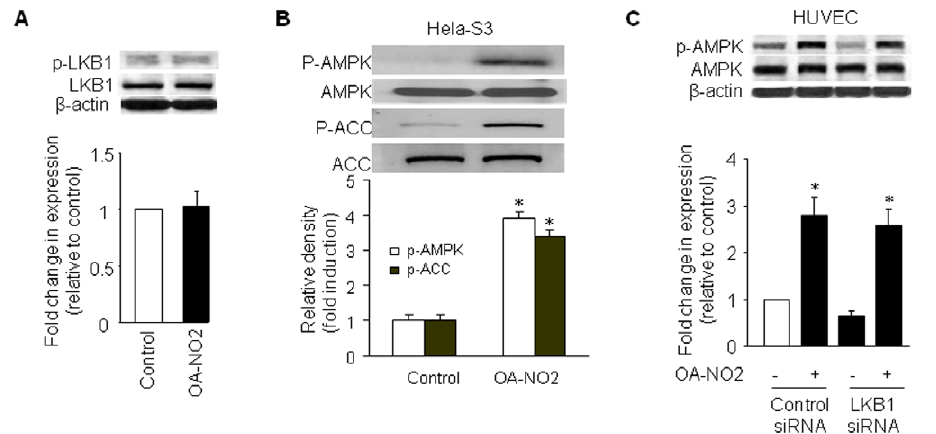
Figure 2. Activation of AMPK by OA-NO 2 does not require LKB1. A ) Phosphorylation of LKB1 Ser428 was not affected by OA-NO 2 in BAECs. Confluent BAECs were exposed to 2.5 m M OA-NO 2 for 16 h, and phosphorylated LKB1-Ser428 was detected by a phospho-specific antibody in western blots. The blot is a representative of three blots obtained from three independent experiments. Lower panels : summary data ( n =3). B ) LKB1 is not required for AMPK activation by OA-NO 2 . Confluent LKB1-deficient Hela-S3 cells were exposed to 2.5 m M OA-NO 2 for 16 h, and then AMPK and ACC phosphorylation were assayed as described in Materials and Methods. The blot is representative of three blots obtained from three independent experiments. Lower panels : summary data (* p , 0.05 vs. control; n =3). C ) LKB1 siRNA did not abolish OA-NO 2 -stimulated AMPK activation in HUVECs. HUVECs were incubated with LKB1-specific siRNA or control siRNA for 48 h and then treated with OA-NO 2 or vehicle for 16 h. After treatment, cell lysates were analyzed for LKB1 protein levels and AMPK phosphorylation at Thr172. Lower panels : summary data (* p , 0.05 vs. control; n =3).